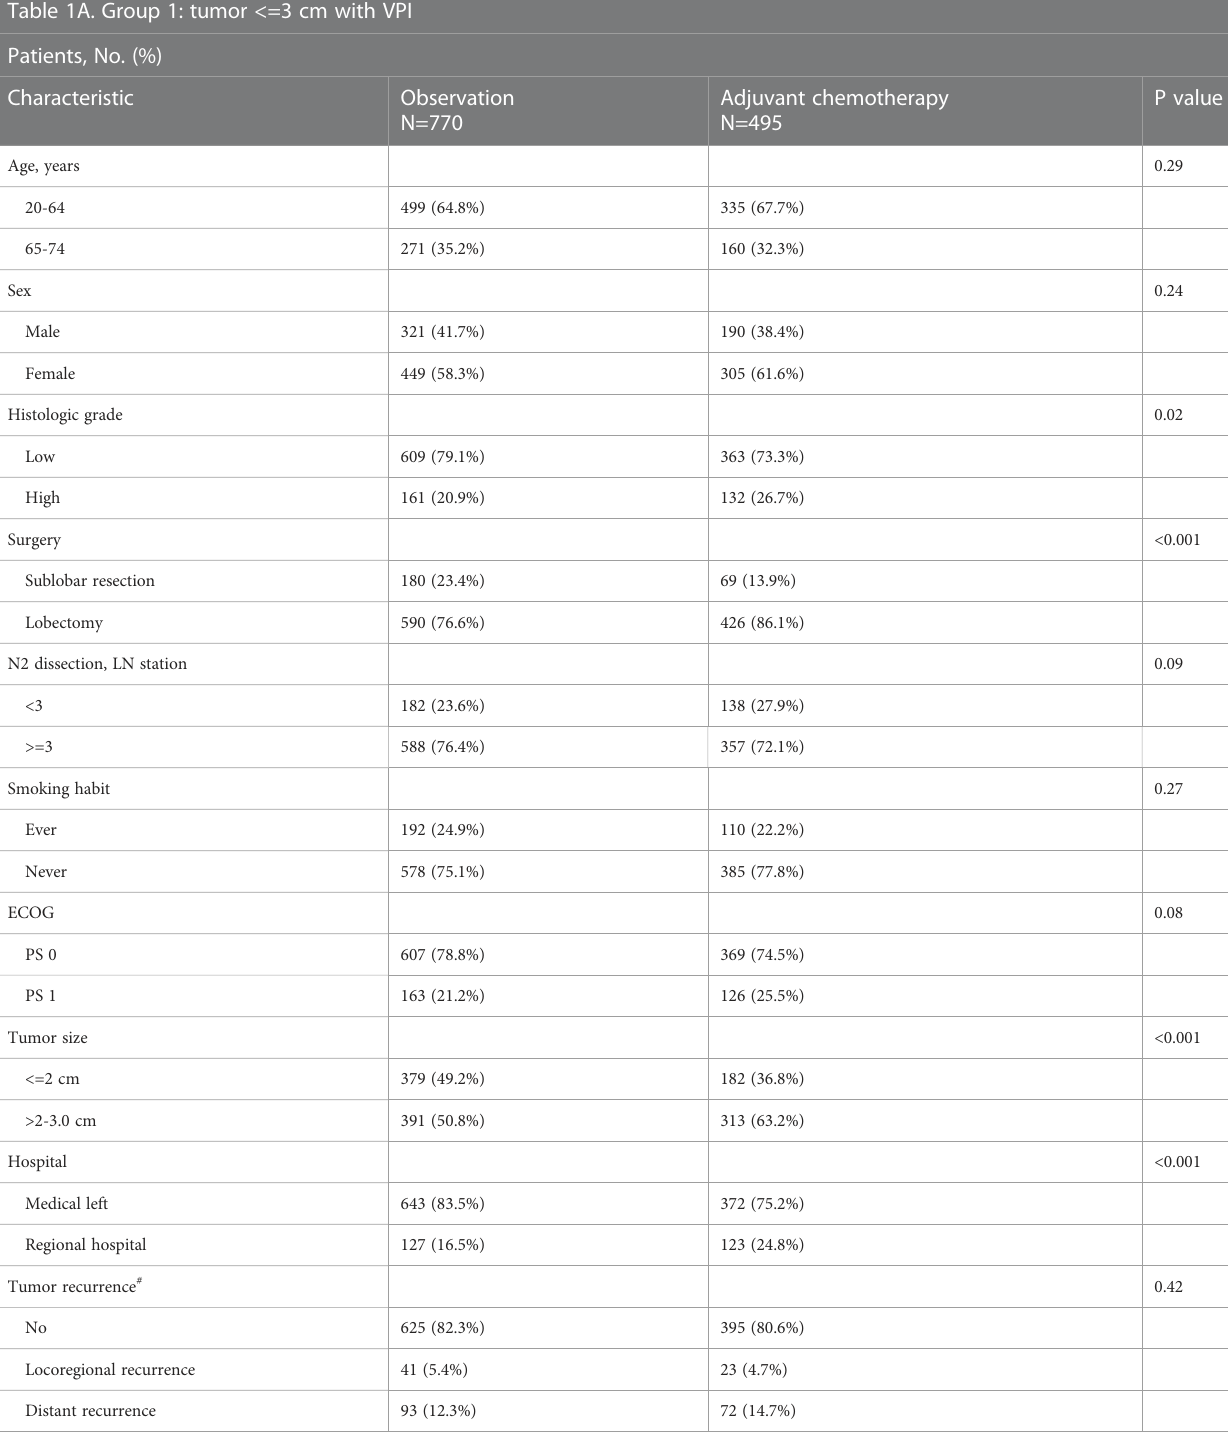
Table 1A. Group 1: tumor <=3 cm with VPI Patients, No.